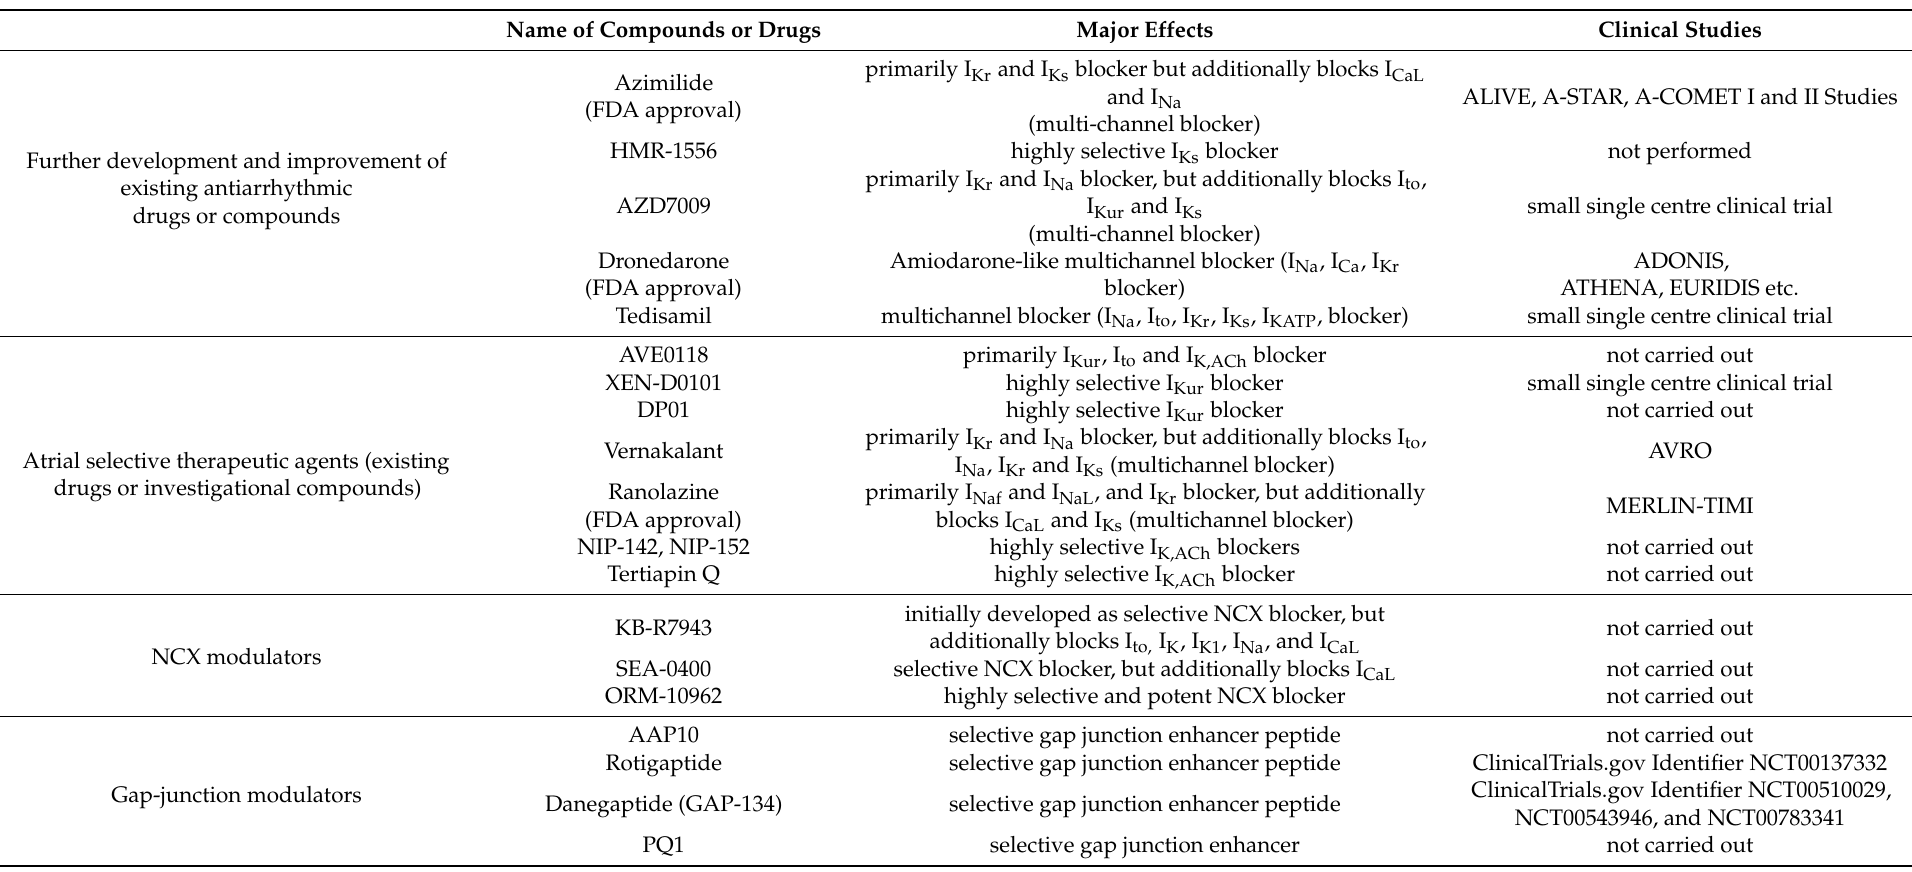
Table 1. Summary of the new drugs and investigational compounds developed for treating AF presented in this